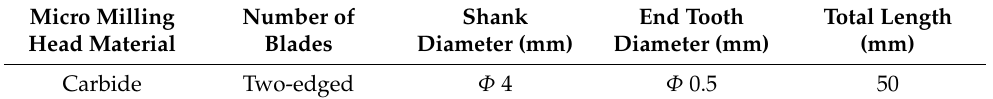
Table 5. Parameters of the micro-milling tool used in the test.